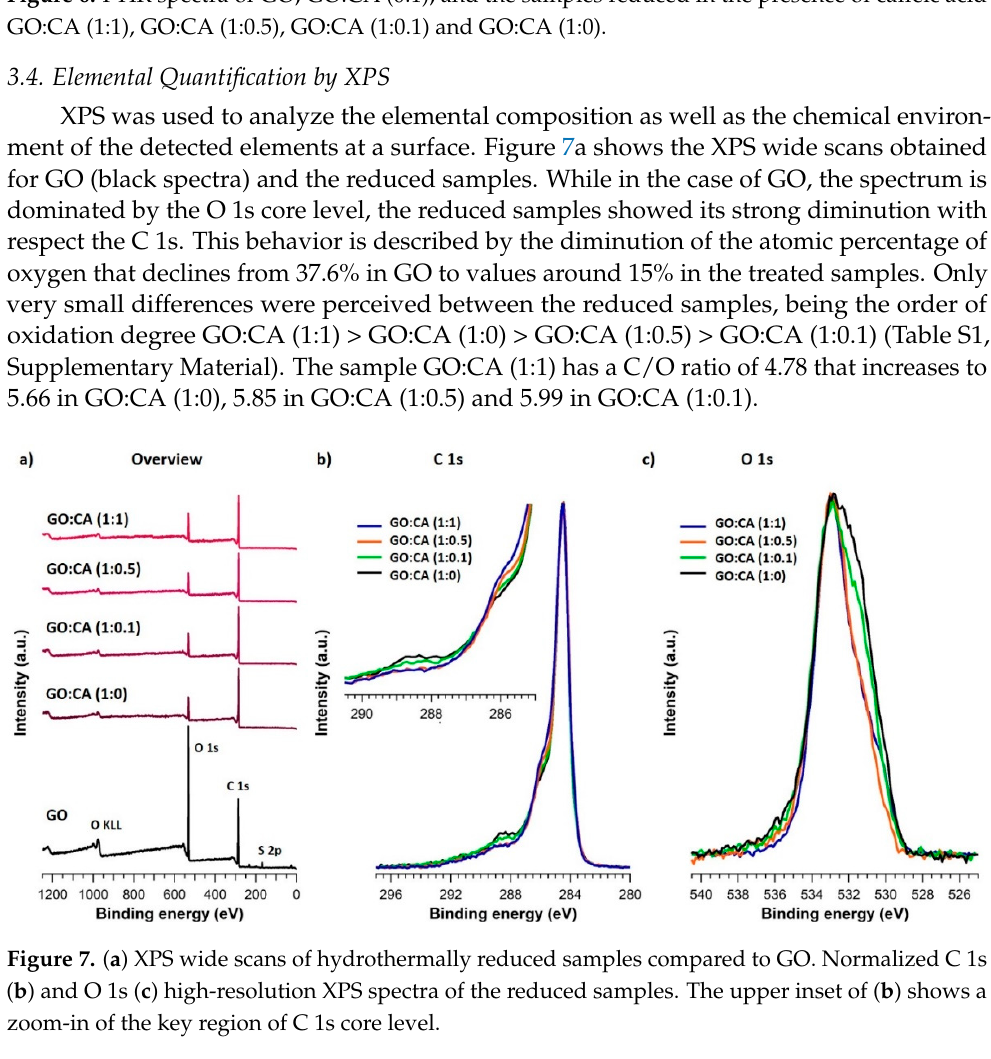
Figure 6. FTIR spectra of GO, GO:CA (0:1), and the samples reduced in the presence of caffeic acid